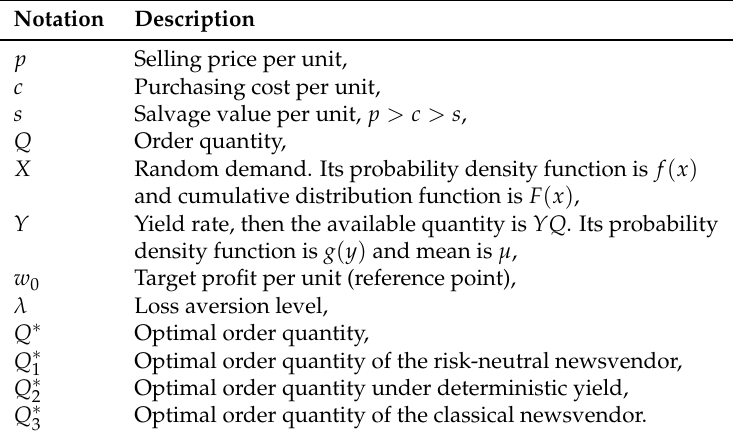
Table 1. Summary of the